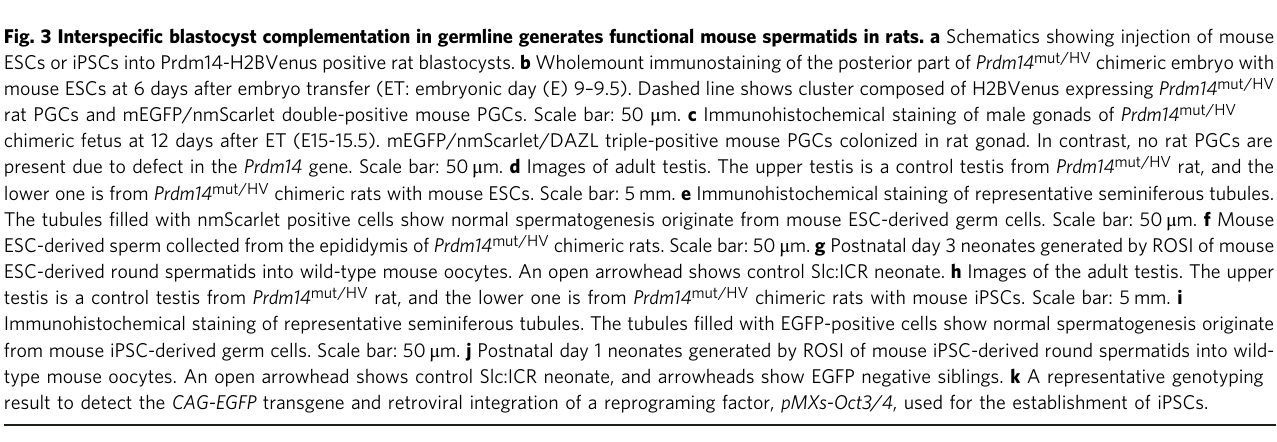
Fig. 3 Interspeci fi c blastocyst complementation in germline generates functional mouse spermatids in rats. a Schematics showing injection of mouse ESCs or iPSCs into Prdm14-H2BVenus positive rat blastocysts. b Wholemount immunostaining of the posterior part of Prdm14 mut/HV chimeric embryo with mouse ESCs at 6 days after embryo transfer (ET: embryonic day (E) 9 – 9.5). Dashed line shows cluster composed of H2BVenus expressing Prdm14